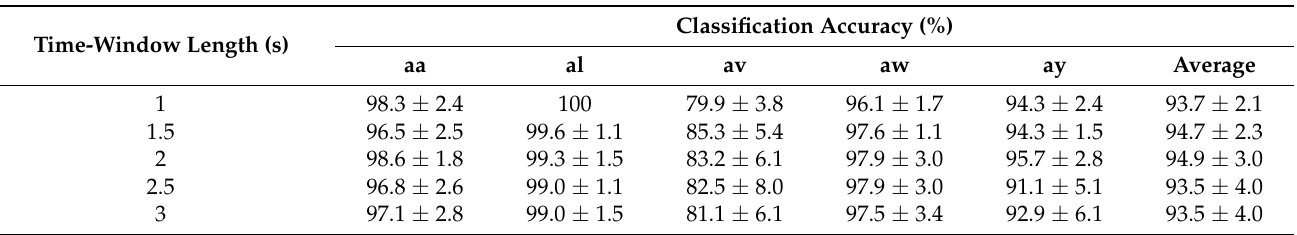
Table 4. The classification accuracies at different time-window lengths on BCI Competition III dataset